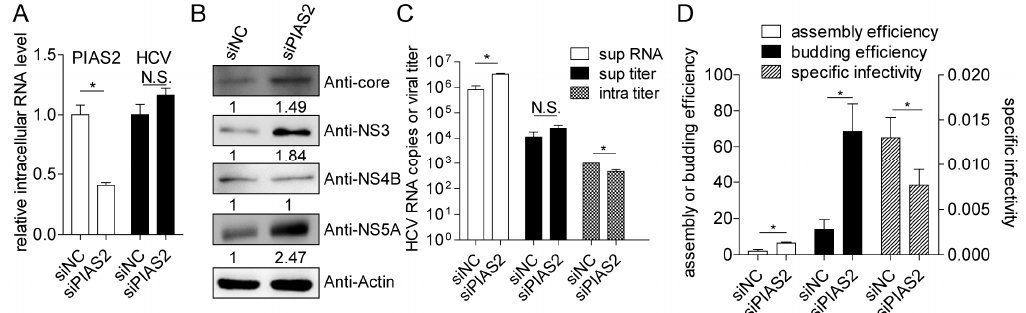
Figure 1. Endogenous protein inhibitor of activated STAT2 (PIAS2) functions as a restriction factor for hepatitis C virus (HCV) infection. Huh7 cells were transfected with a small interference RNA (siRNA) as indicated and then infected with J399EM at an multiple of infection (MOI) of 0.1 for 72 h. RNA and protein samples were collected to determine the relative intracellular PIAS2 mRNA levels and HCV RNA levels ( A ); and the HCV core, NS3, NS4B, and NS5A protein levels ( B ); ( C ) the HCV RNA level in the supernatant (sup RNA), viral titer in the supernatant (sup titer), and intracellular viral titer (intra titer) were determined; ( D ) the assembly efficiency (super RNA/intra RNA), budding efficiency (super titer/intra titer), and specific infectivity (super titer/super RNA) were calculated. siNC: scramble siRNA as negative control. N.S: not significant, * p < 0.05.